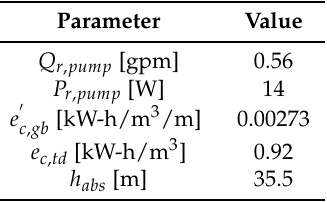
Table 2. Parameters of energy demand for water consumption calculation.